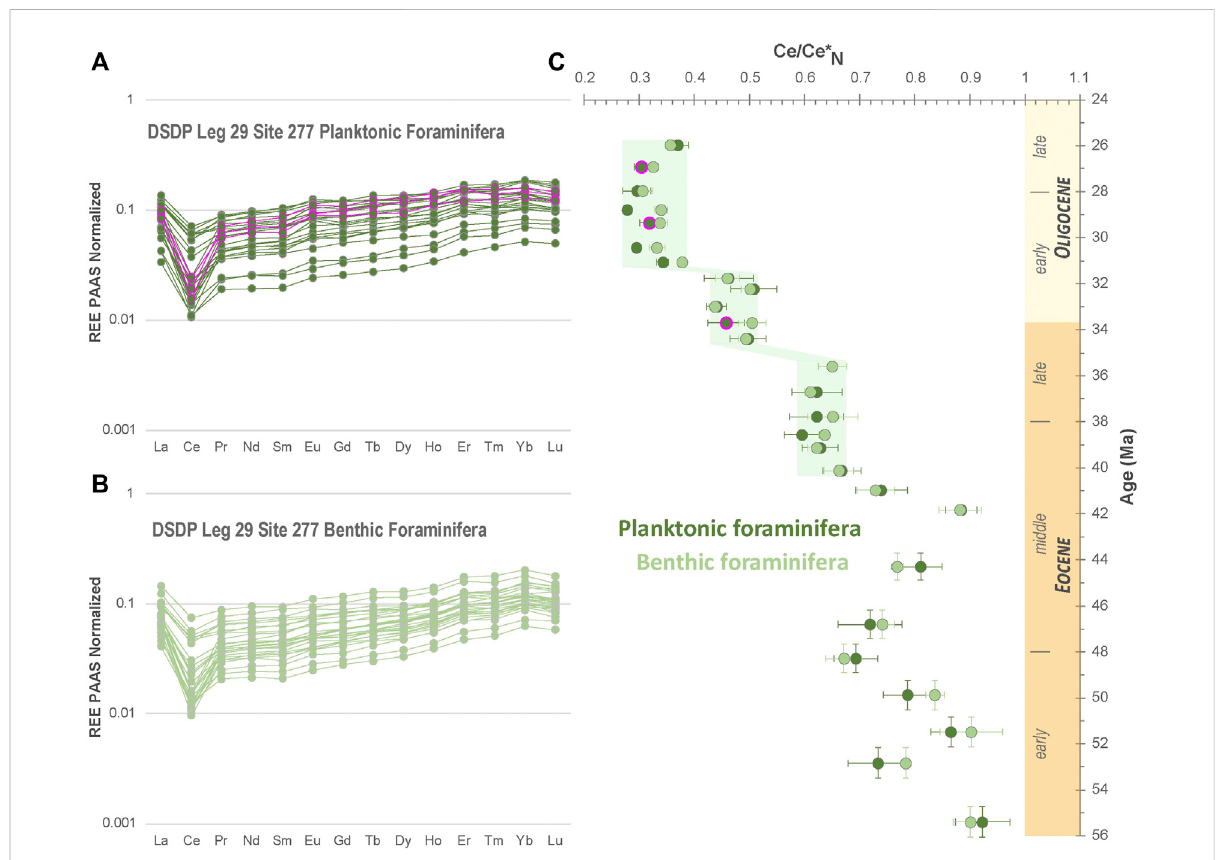
FIGURE 4 (A,B) PAAS normalized REE spectrum of the studied (A) planktonic ( Subbotina sp. ) and (B) benthic foraminifera ( Cibicidoides sp. and Gyroidinoidessp. )testsfromtheDSDPSite277.PAASnormalizingvaluesarefromBarthetal.(2000)withTmfromKamberetal.(2005). (C) Evolution ofthenegativeCeanomaly(Ce/Ce*ratio)alongtheEocene-Oligoceneinterval.Thesampleshighlightedinpinkarethethreesamplesslightlyabove the contamination threshold for Al/Ca and Sr/Ca molar ratios (see Figure